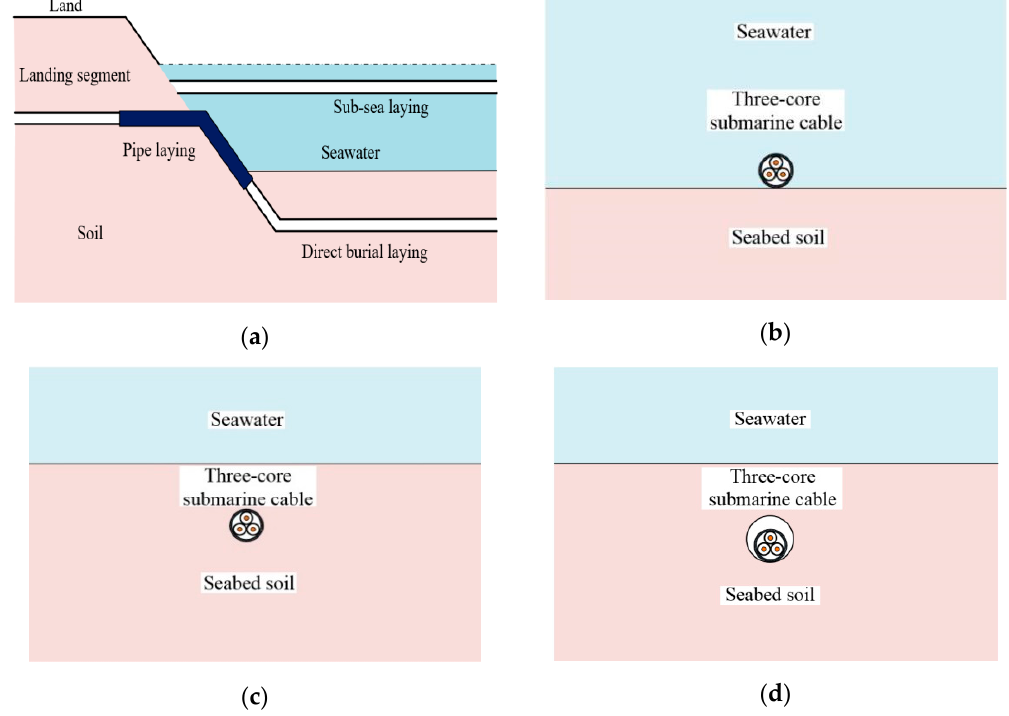
Figure 2. Laying environment of submarine cable. ( a ) Typical laying environment map of submarine cable. ( b ) Sub-sea laying. ( c ) Direct burial laying. ( d ) Pipe laying.